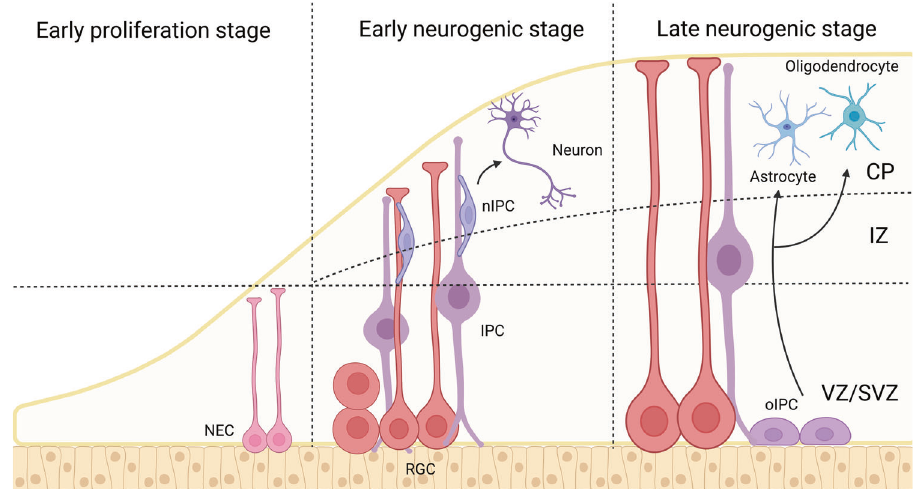
Fig. 1 Embryonic neurogenesis. Neuroepithelial cells (NECs) give rise to radial glial cells (RGCs). RGCs divide asymmetrically to produce neuron and neuroglial cells (astrocyte and oligodendrocyte) through neurogenic intermediate progenitor cell (nIPC) and oligogenic intermediate progenitor cell (oIPC), respectively. CP cortical plate, IZ intermediate zone, SVZ subventricular zone, VZ ventricular